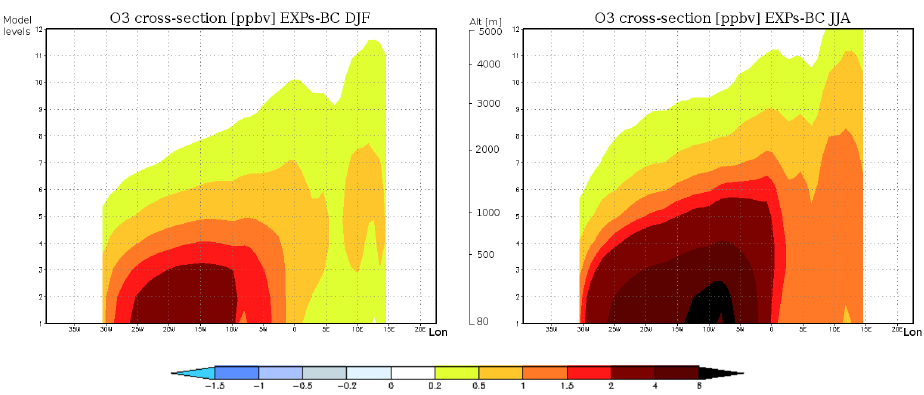
Fig. 6. Vertical cross-section along latitude 45.2 ◦ N of winter (left) and summer (right) average ship induced O 3 in ppbv as difference of experiments EXPs and BC with approximate altitudes.